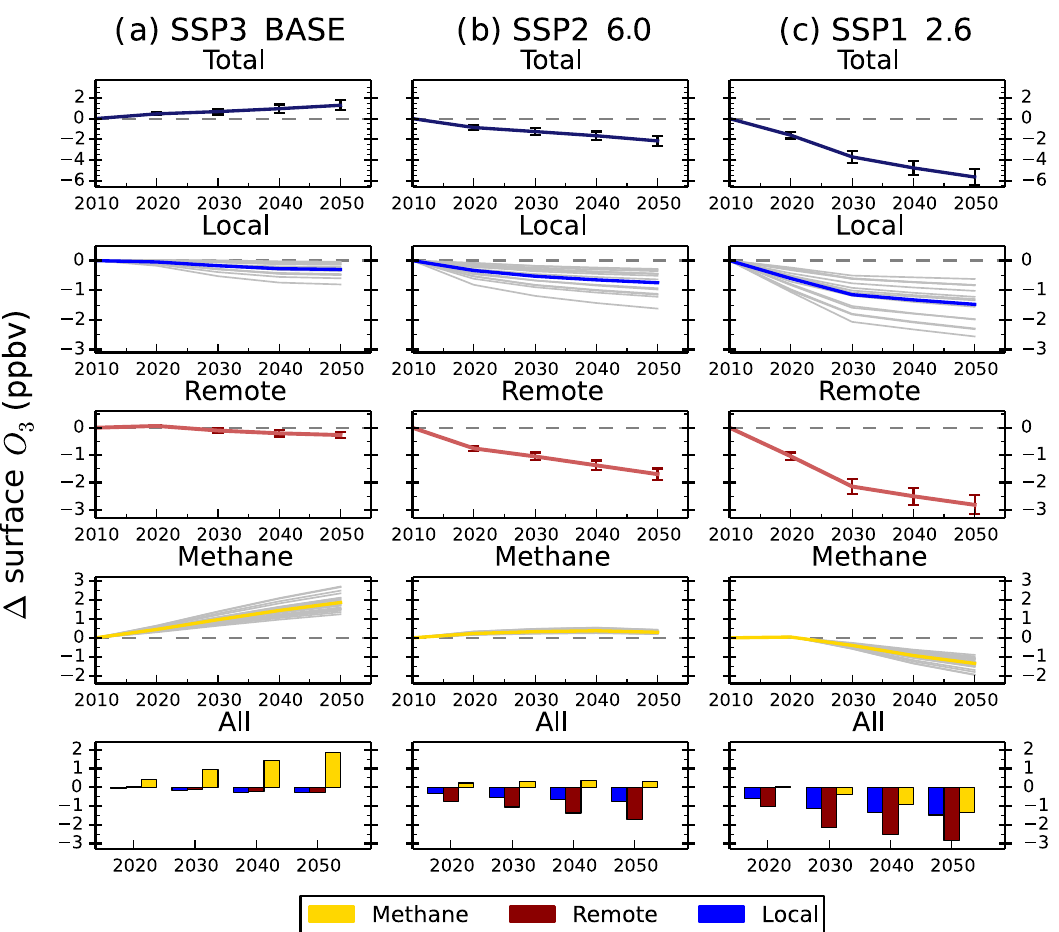
Figure 10. Total annual mean change in regional surface O 3 concentrations over Europe and the contribution of local (blue), remote (red) or methane (gold) sources between 2010 and 2050 from the parameterisation for the CMIP6 emission scenarios of SSP3 BASE (a) , SSP2 6.0 (b) and SSP1 2.6 (c) . Grey lines on the local and methane panels represent individual model estimates of O 3 changes, showing the spread in model responses; solid lines show the multi-model mean. Error bars represent 1 standard deviation over the model range. The last row of panels shows the O 3 response from individual sources plotted together for each